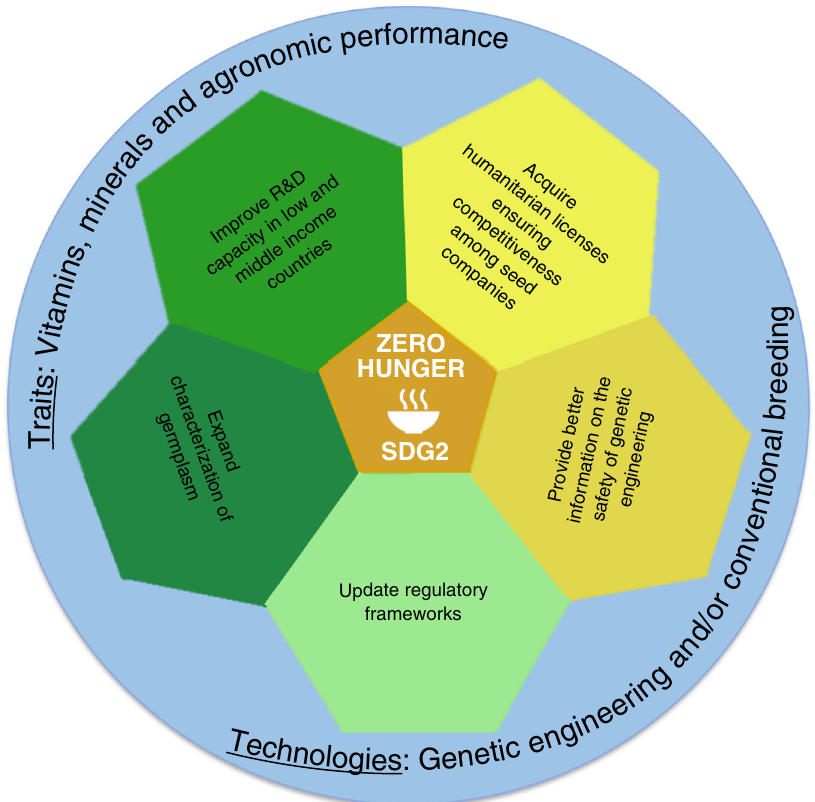
Fig. 2 Proposed actions and policy interventions. Achieving zero hunger (UN-Sustainable Development Goal 2, UN-SDG2) requires actions (green- yellow) using different tools and trait/technology combinations (blue). Yellow-labeled actions speci fi cally aim to achieve better accessibility by the poor, whilst green-labeled actions aim to acquiring more ef fi cient product development (light green involves genetic engineering only, dark green includes both genetic engineering and conventional breeding).